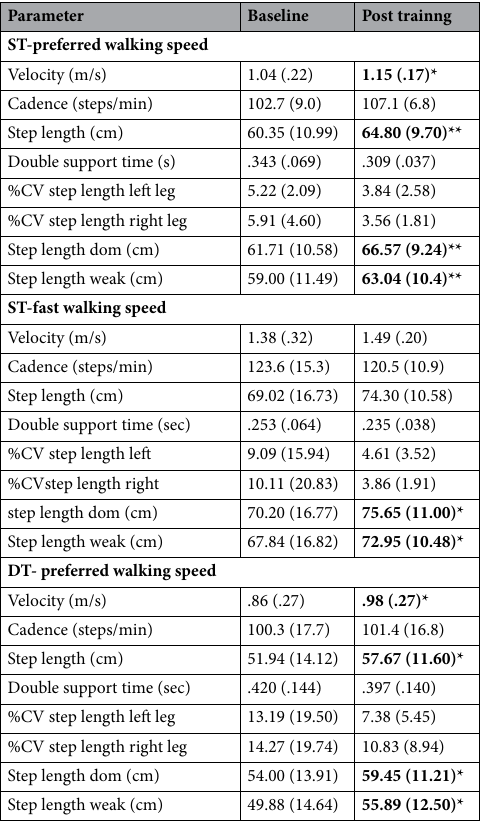
Table 3. Gait Parameters at baseline and post training in the total PD group. The bold values indicate a p -value < 0.05. * p < 0.05; ** p < 0.01. For gait variability (%CV) = Coefficient of Variation of step length (CV) following formula was used: %CV = (standard deviation/mean) ×